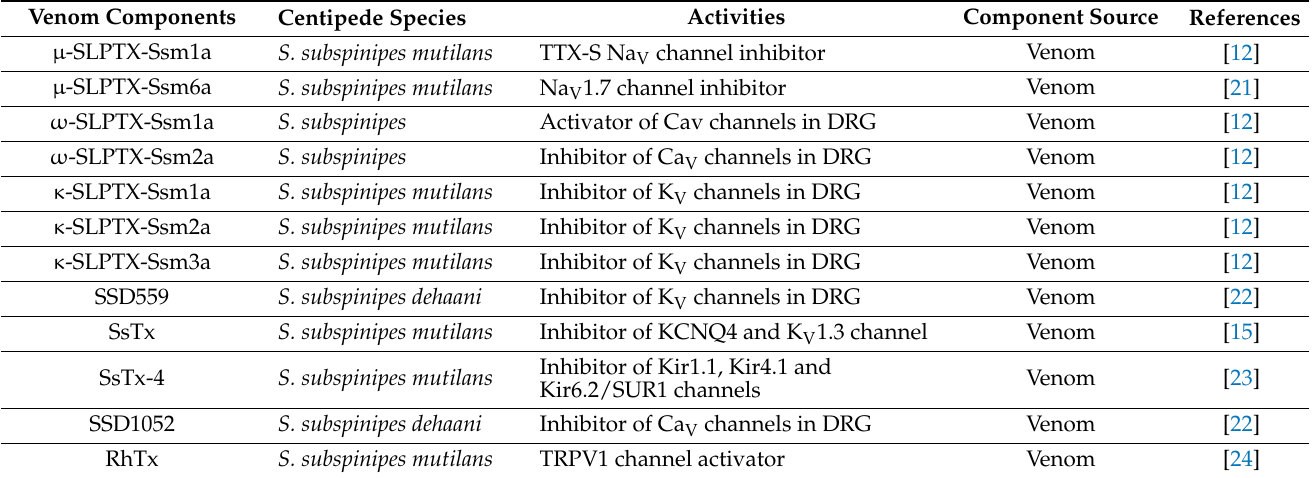
Table 1. Representative functional components derived from